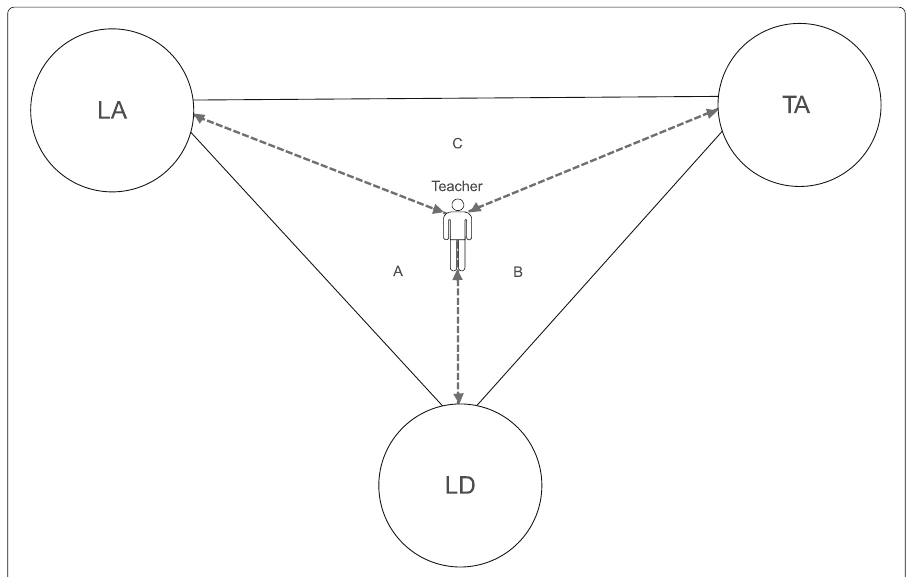
Fig. 4 Conceptualisation of TA. Triadic TA Conceptual